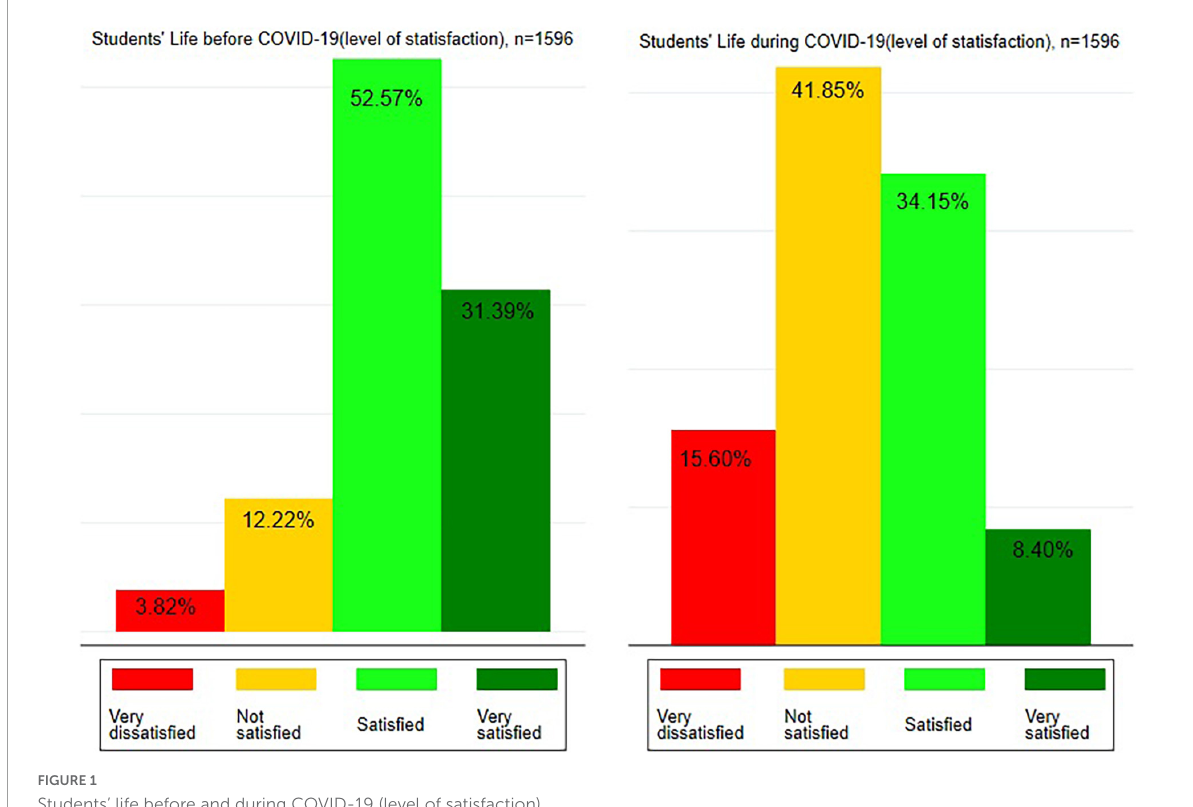
FIGURE1 Students’ life before and during COVID-19 (level of satisfaction).